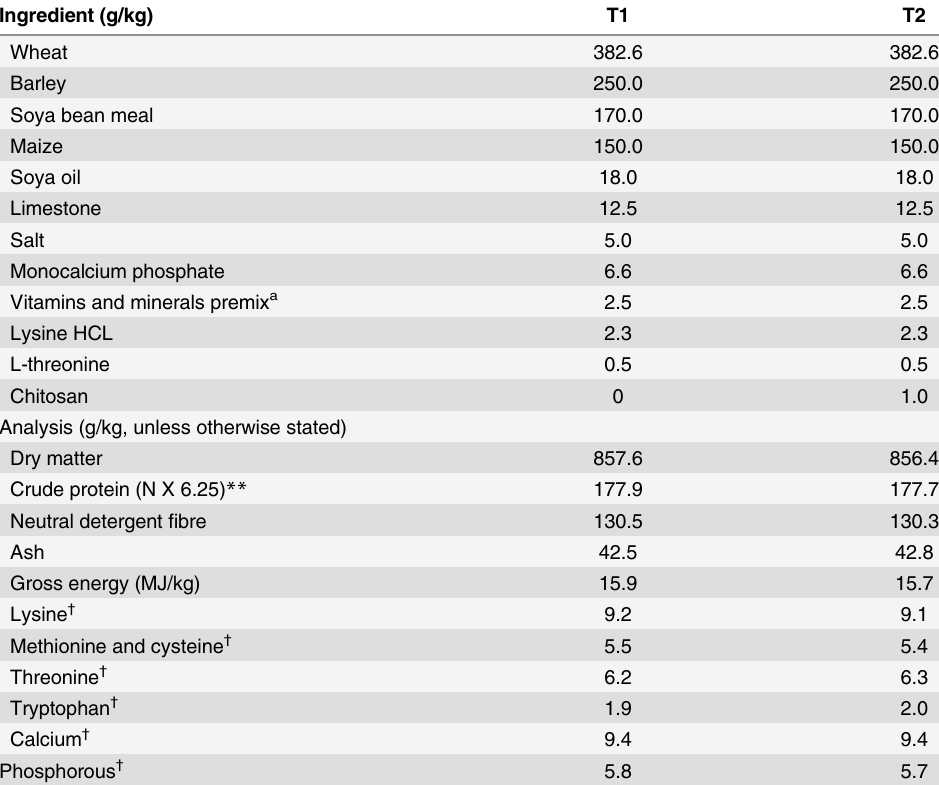
Table 1. Diet composition and chemical analysis (g/kg, unless otherwise indicated). Ingredient